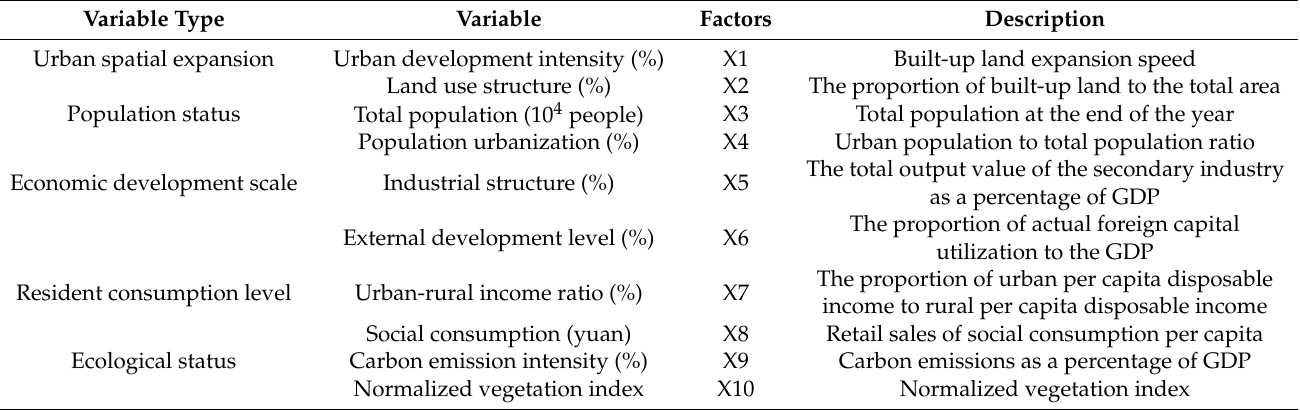
Table 4. Potential influencing factors of land pressure in the